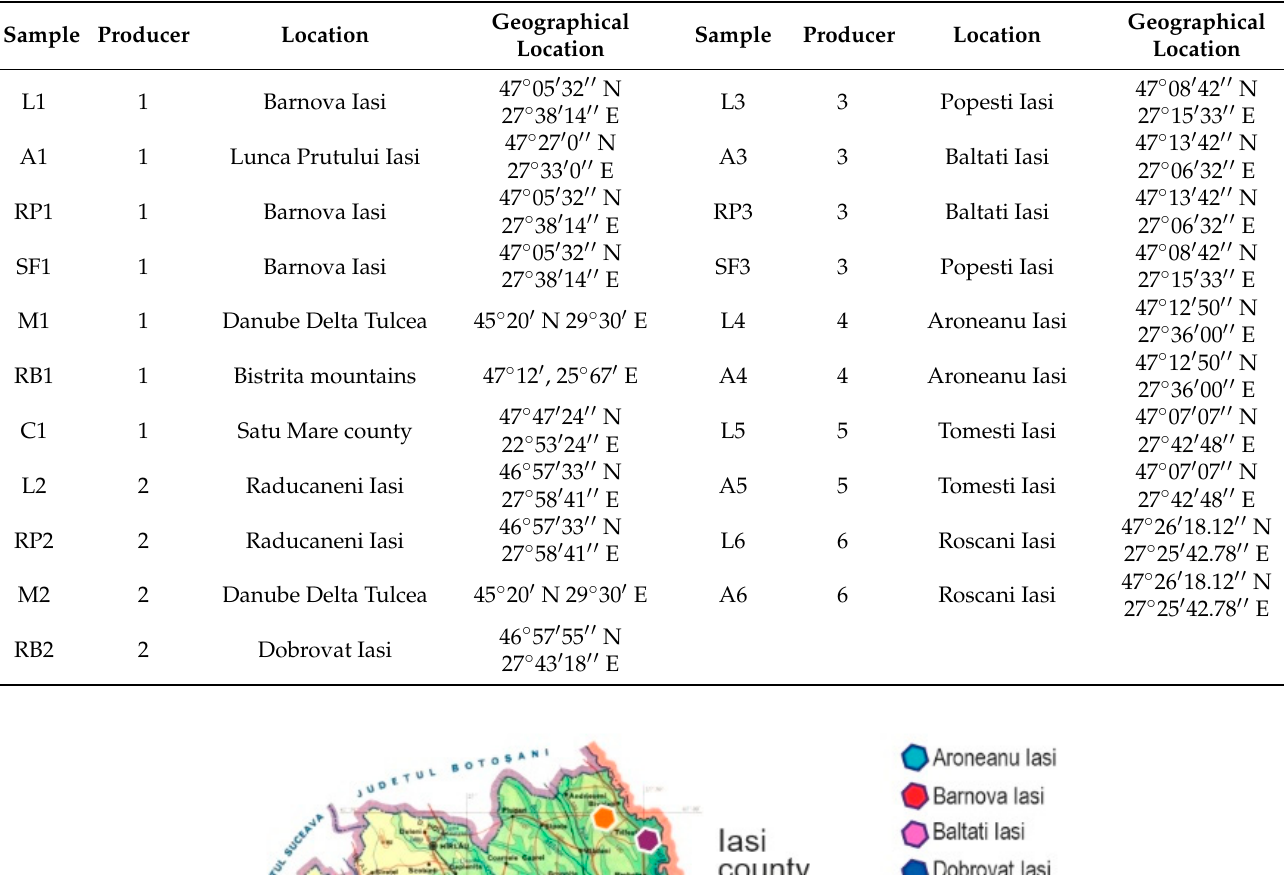
Table 1. Sample description.